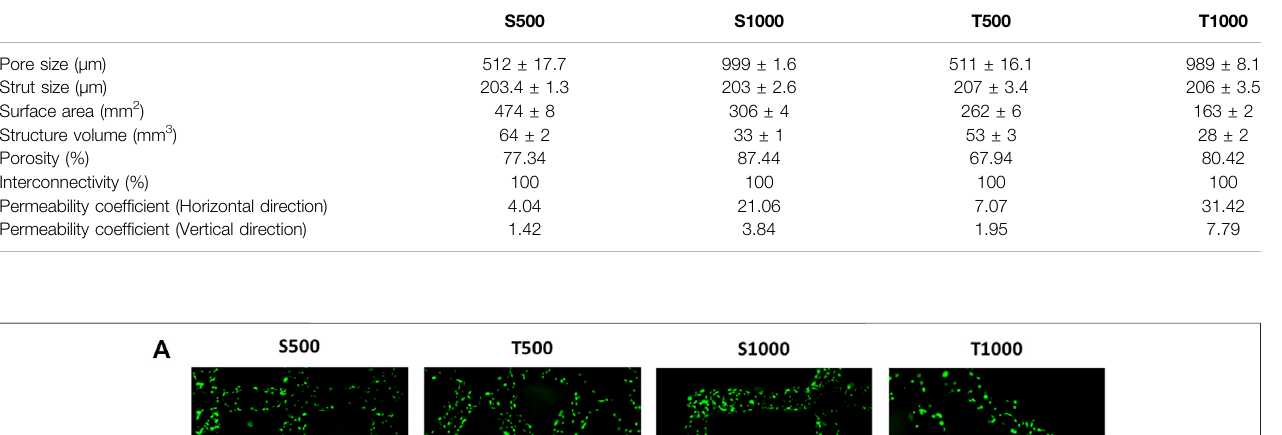
Frontiers in Bioengineering and Biotechnology |